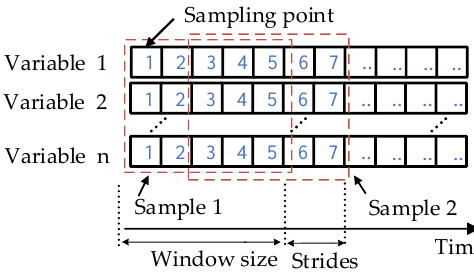
Figure 8. Illustration of data sliding window.